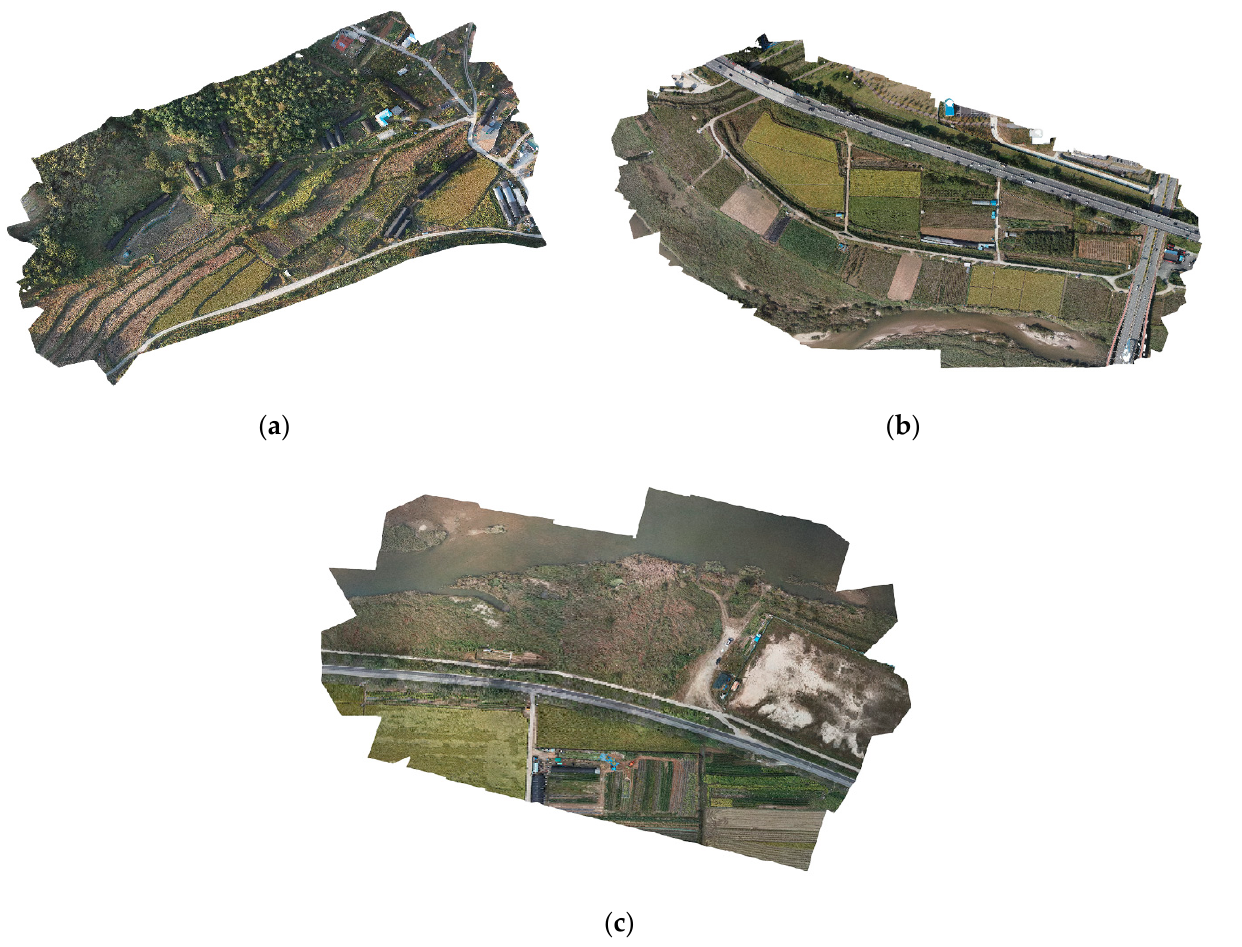
Figure 6. Target sites for data collection in Asan City: ( a ) northern (B1), ( b ) central (B2), and ( c ) southern (B3).